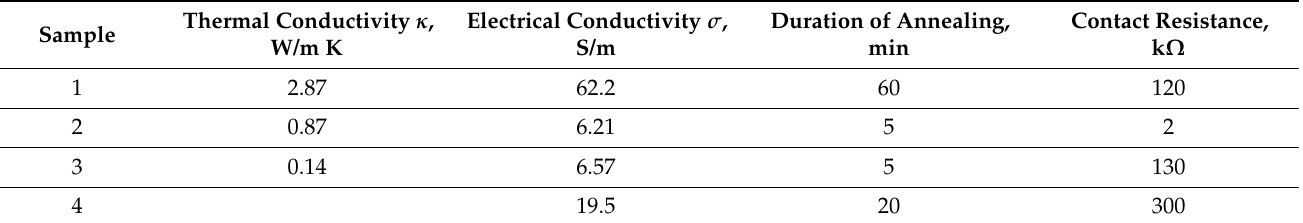
Table 4. Transport characteristics of thermally reduced graphene samples [60].